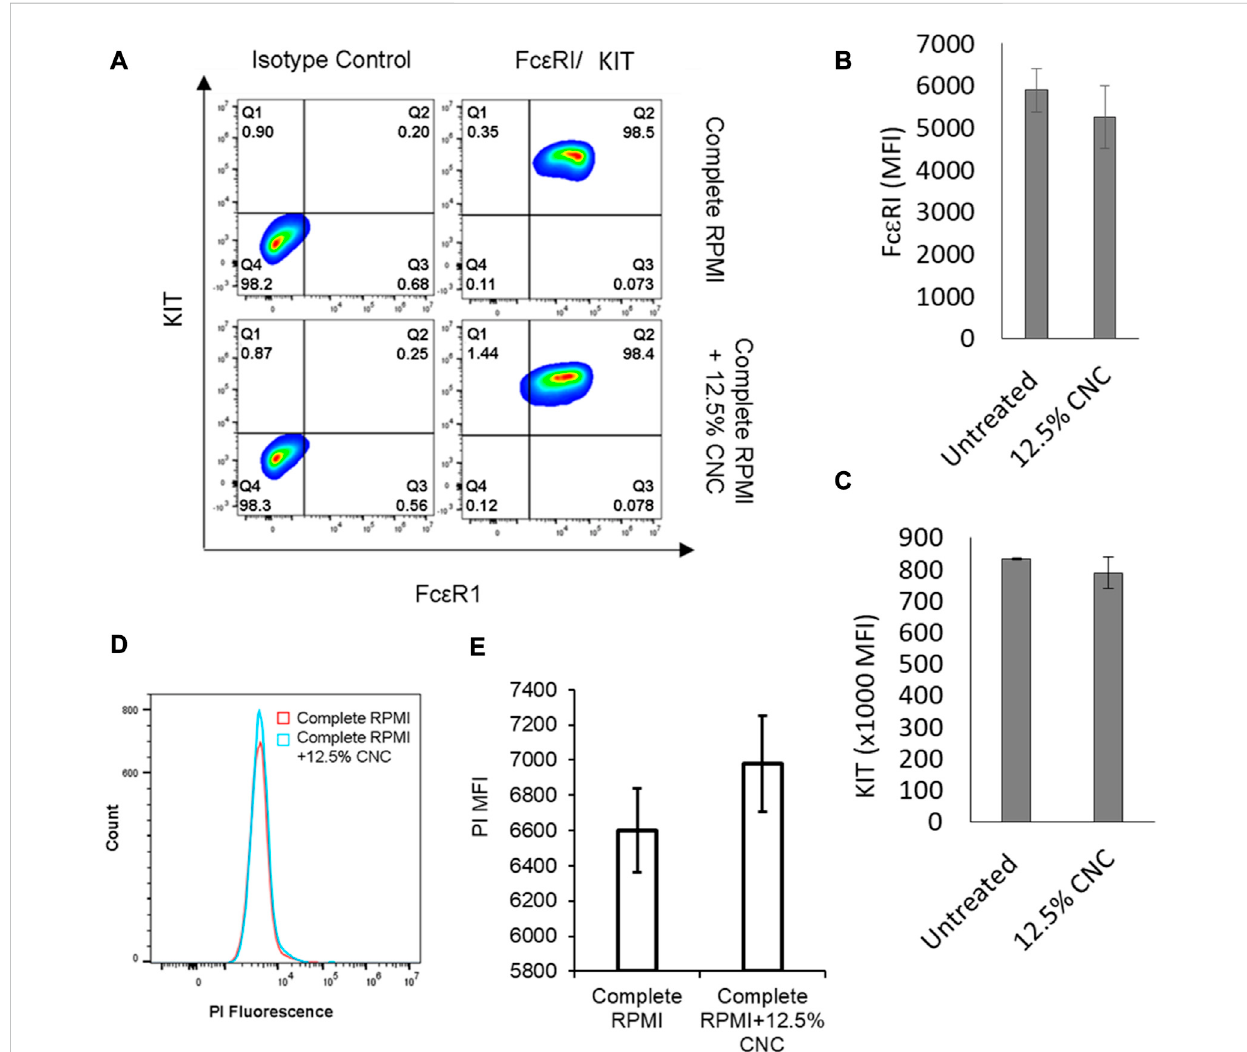
FIGURE 5 Effect of CNC/agarose substrates supplemented with complete RPMI on phenotypic expression and plasma membrane integrity of BMMC. (A) BMMCs were cultured in absence (Complete RPMI) or presence (Complete RPMI +12.5% CNC) of CNC/agarose substrates for 24 h. Cells were removed and analyzed for receptor expression by labeling with either the isotype controls or antibodies. KIT ( Y -axis) versus FcsRI ( X -axis) expressioncontour plots are representative of 3 independent experiments. BMMC were cultured on 0% – 12.5% CNC/agarose as in (A) and expression of FcsRI (B) and KIT (C) mean fl uorescenceintensitywasdeterminedby fl owcytometry(MFI; n =3). (D) Histogramoverlaypro fi legeneratedfrompropidiumiodide(PI)exclusion assayofcellstreatedasin (A) . (E) GraphicalrepresentationofMFIofPI-stainedcellsasinB;datapresentedisaveragemean fl uorescenceintensity(MFI)of 3 independent